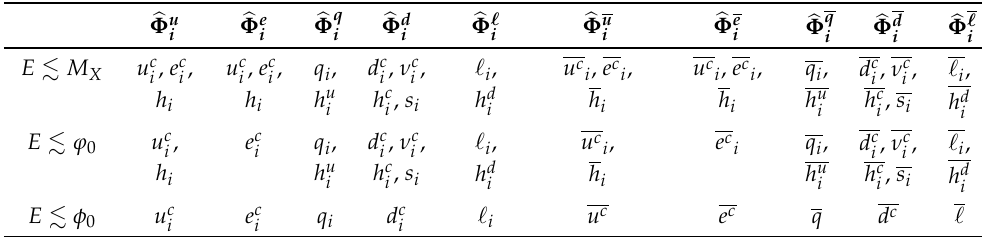
Table 3. The bulk supermultiplets and their zero modes that remain massless below the scales M X , ϕ 0 and φ 0